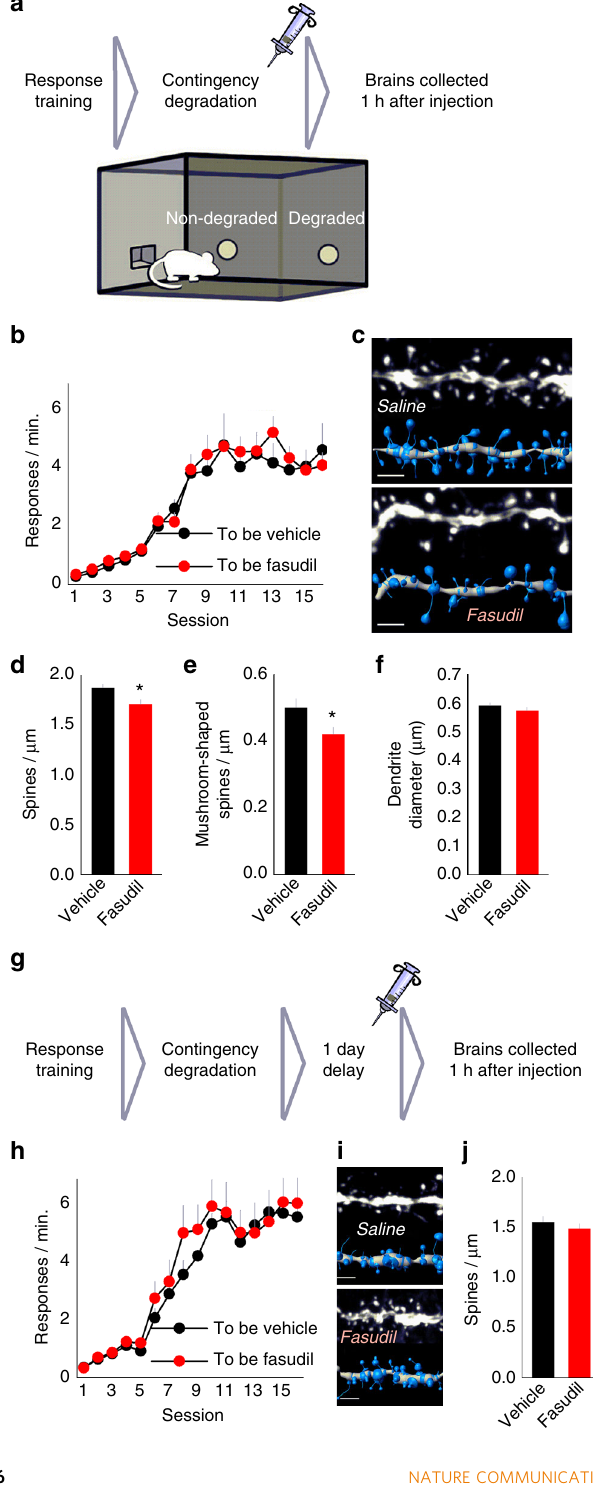
Fig. 4 Selective remodeling of prelimbic cortical dendritic spines. a Experimental timeline: mice were given extensive response training to promote habit-based responding. A systemic injection of vehicle or fasudil was administered immediately following instrumental contingency degradation, with brains collected 1 h after the injection ( n = 8, 9 per group). b Mice acquired the instrumental responses, with no group differences. c Prelimbic cortical dendritic segments with corresponding digital reconstructions below. d Fasudil reduced prelimbic cortical dendritic spine density. e Dendritic spine classi fi cation revealed that speci fi cally, mushroom-shaped spines were pruned, with fasudil-exposed